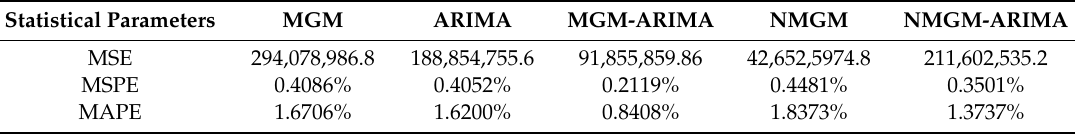
Figure 22. The predicted value of the five models and the actual power generation. (Column chart, GWh).